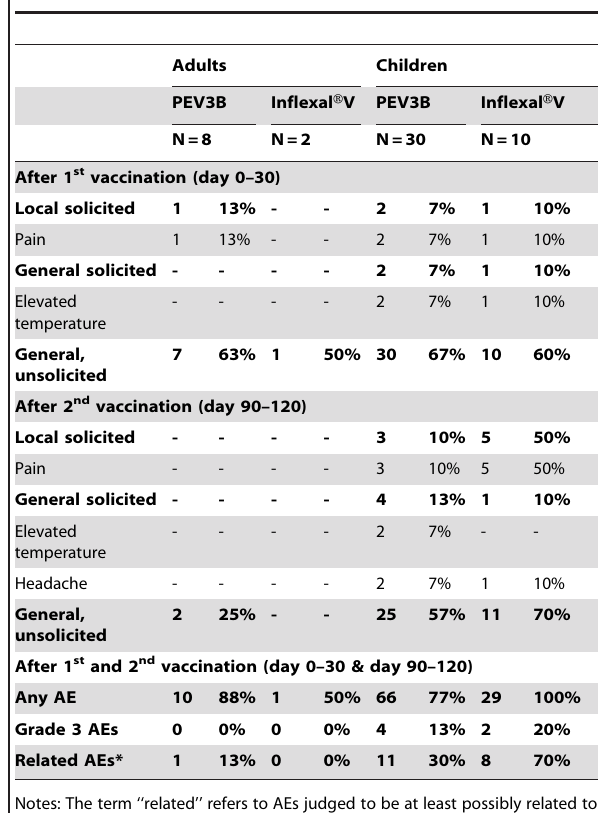
Table 1. Summary table of solicited (local and general) and unsolicited (general) adverse events occurring within 30 days after